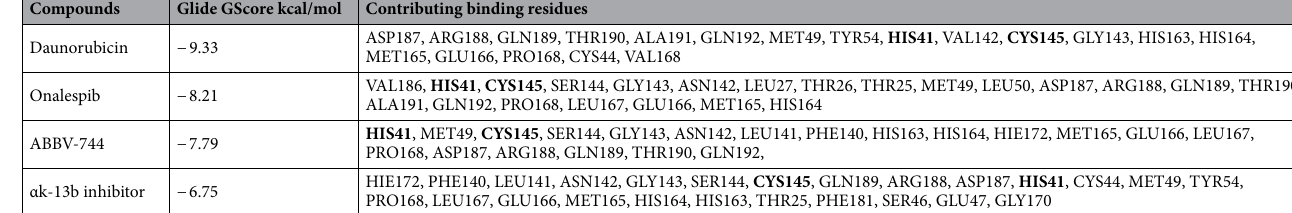
Table 1. The best three compounds generated using XP docking with their corresponding docking scores and the contributing binding residues are presented. Catalytic dyad residues are shown in